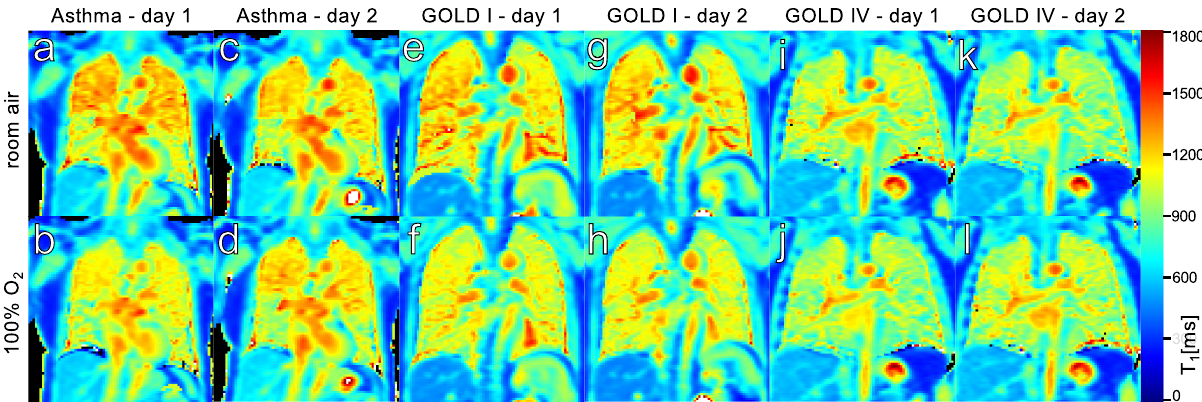
Fig 2. Example T 1 maps, acquired in one asthma (a-d) and two COPD (g-k) patients from different GOLD stages. The maps in the upper row were measured at 21%O 2 in the breathinggas, the lower row duringadministration of 100%O 2 . For each patient, T 1 maps from equivalentslices on both measurement days are shown to illustrate reproducibility.